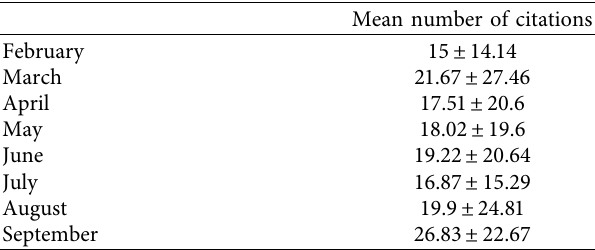
Table 2: The mean ± SD number of citations per article, by month of